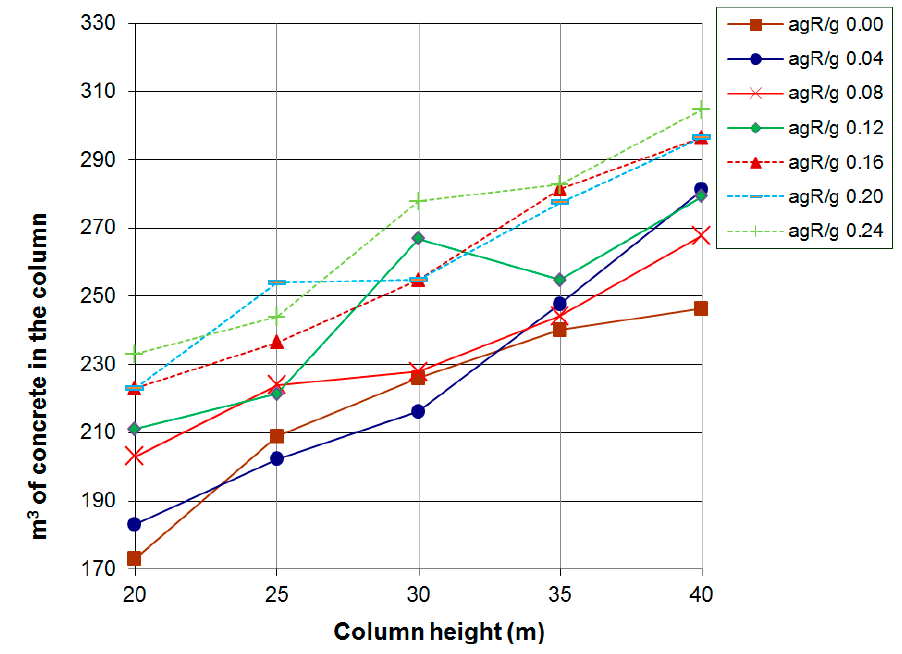
Figure 9. m 3 of concrete in the column versus height of the column.